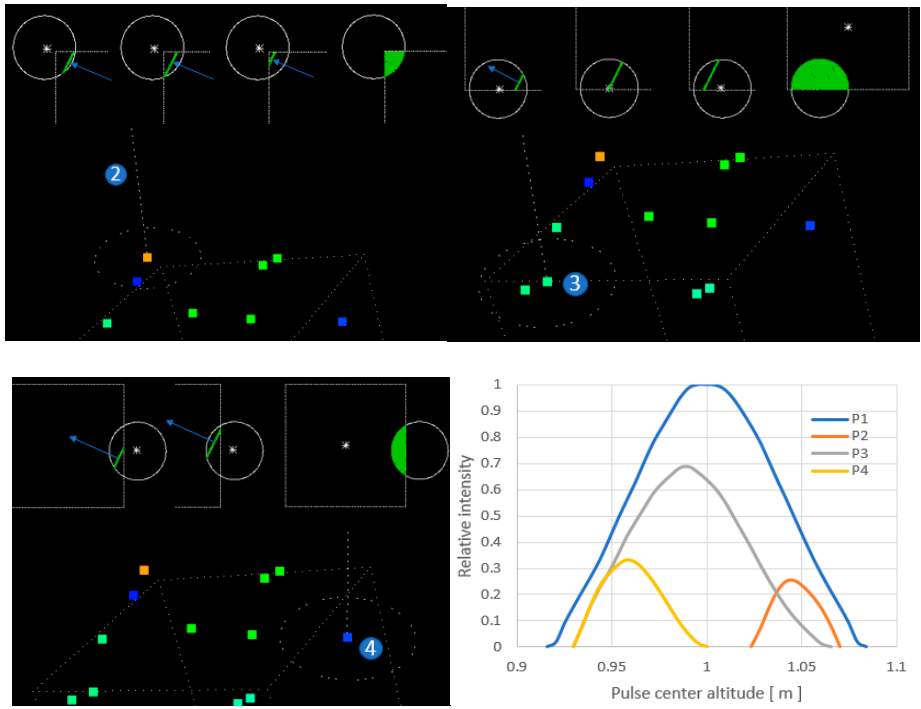
Figure 7. The beam interaction examples for 3 more points and the waveform near the target. The maximum intensity of each waveform corresponds to the z-altitude of the lidar point computed by direct